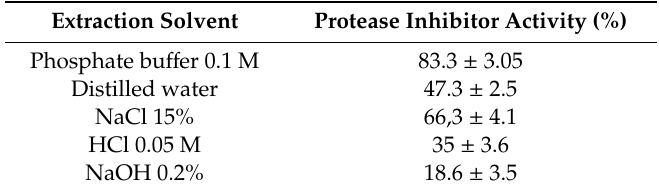
Table 1. Activity of protease inhibitor extracted from C. dioscoridis using di ff erent